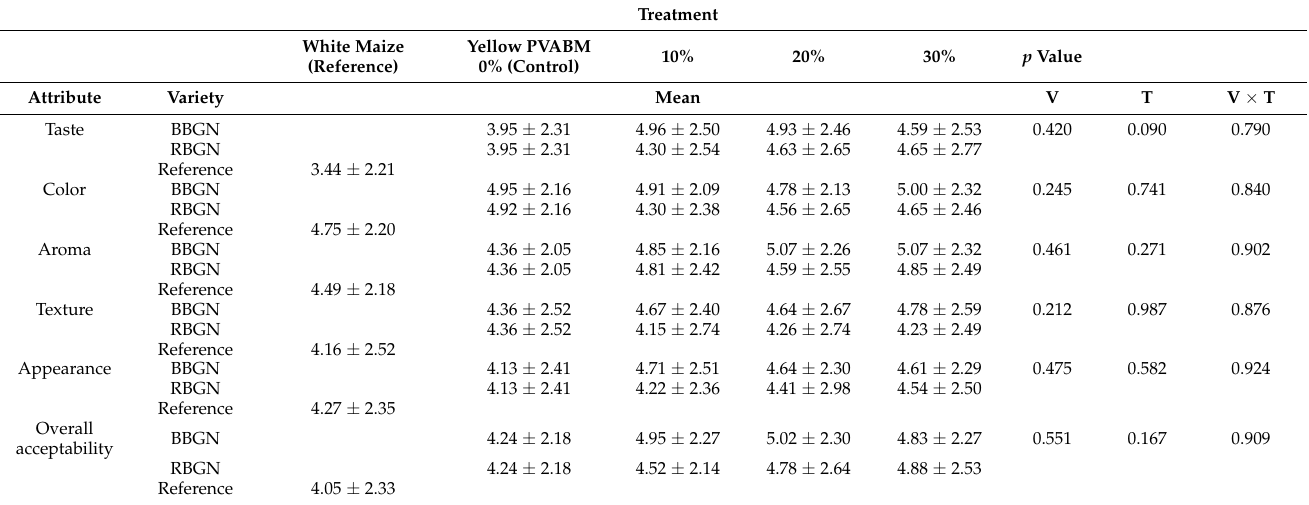
Table 8. Sensory acceptability of BGN–PVABM composite complementary instant porridges. Treatment